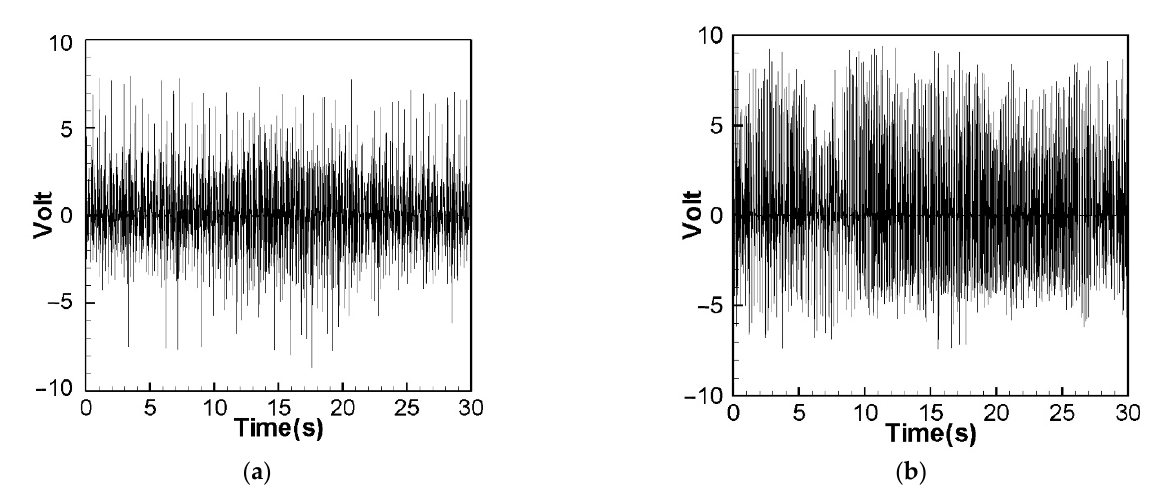
Figure 16. Theoretical voltage prediction for “nonlinear” frequency excitation. ( a ) 1st mode, ( b ) 2nd mode.